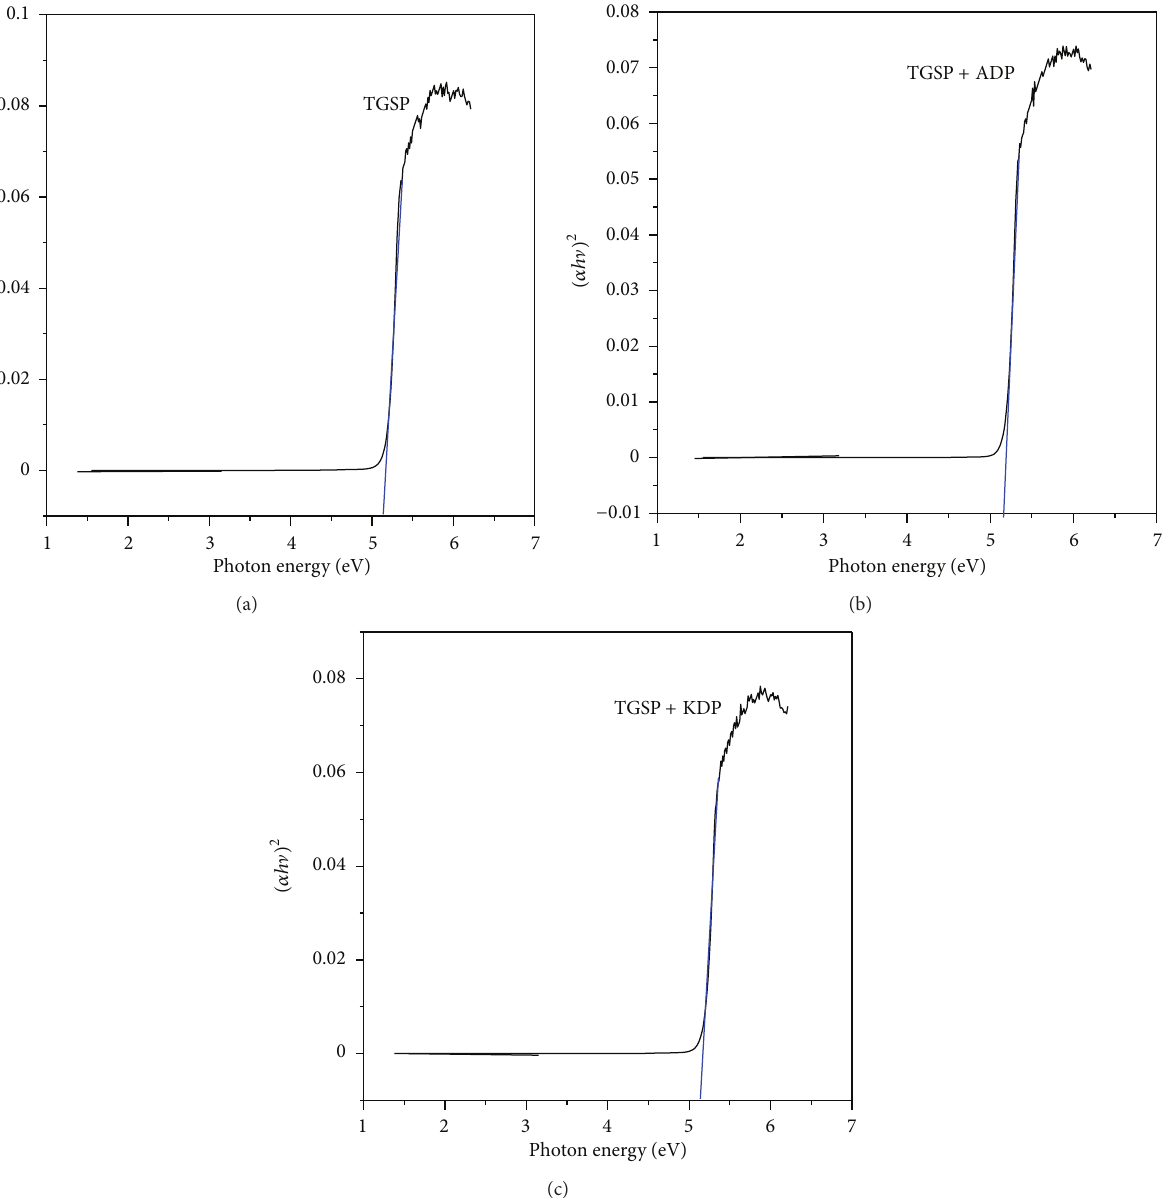
Figure 3: Urbach plot of (a) TGSP, (b) TGSP + ADP, and (c) TGSP + KDP